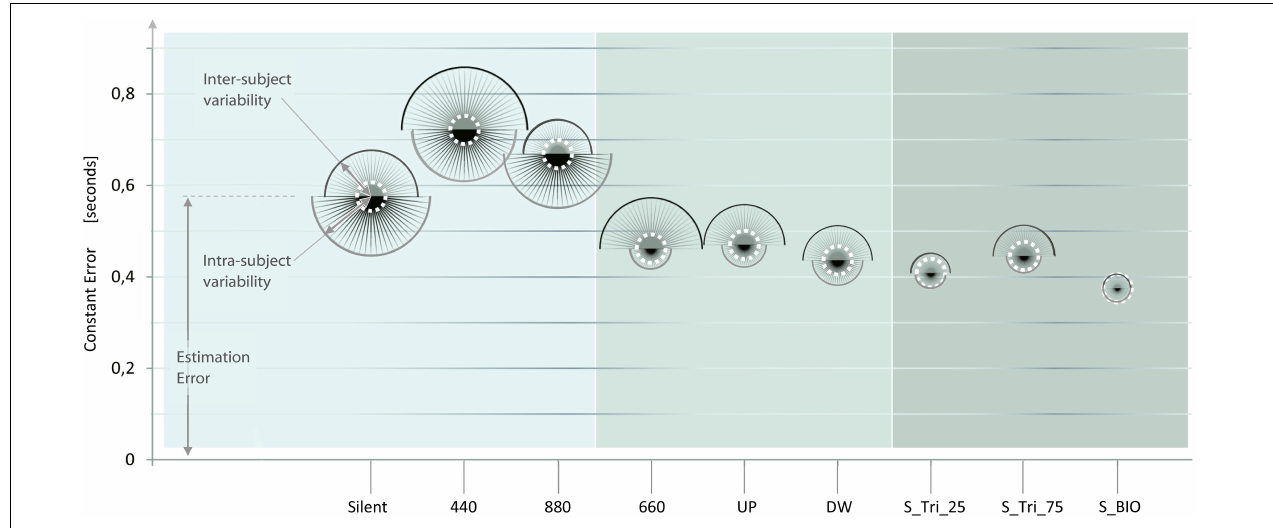
FIGURE 6 | Effect of the Sound structure on the accuracy and precision time estimation. The results of the three experiments are presented in sequence, from left (Experiment 1, light gray) to right (Experiment 3, darker gray). The x -axis presents the nine sound conditions presented to the participants, from the easier sound (on the left) up to the most complex sound profile (on the right). For each Sound condition, the y-coordinate of each balloon-center represents the Constant Error value (i.e., the inverse of accuracy). Two half-circles compose each balloon and represent respectively: the inter-subject variability (upper half-circle), and the intra-subject variability (lower half-circle). Thus, the sizes of each balloon represent the inverse of the participants’ estimation precision. The lower and the smaller is a balloon, and the more accurate and precise are the answers for the corresponding sound condition. Balloons’ diameters are linearly proportional to the standard deviation of the subjects’ responses, and not-in-scale with the Constant Error. The white dotted line represents the distribution in the “BIO” condition, reported as a reference in the nine sound conditions. The representation of the experiments side by side is purely qualitative and no definitive comparisons can be assumed between experiments.